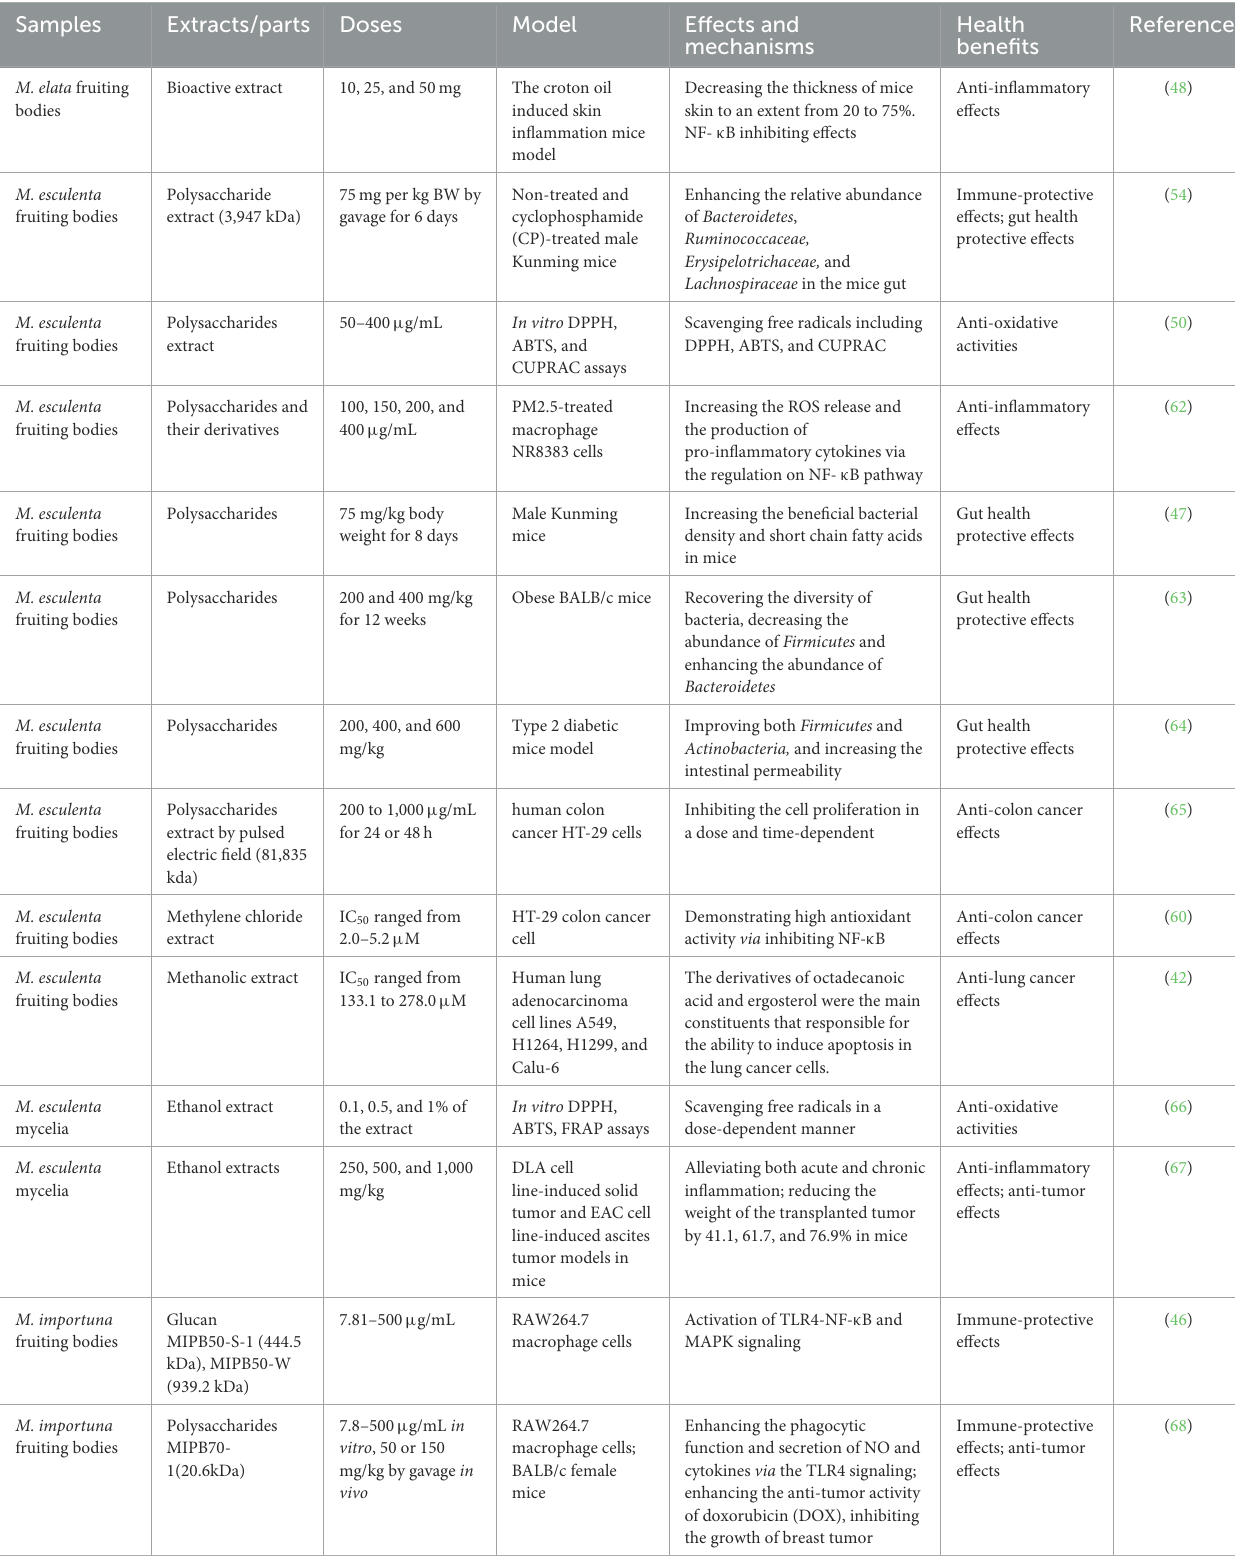
TABLE 5 Health benefits of some morel